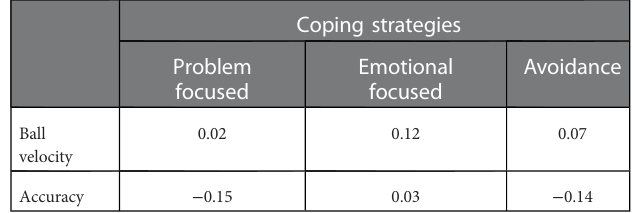
TABLE 2 Correlation between change in throwing accuracy (distance from center of target) and ball velocity with the three different coping strategies. Coping